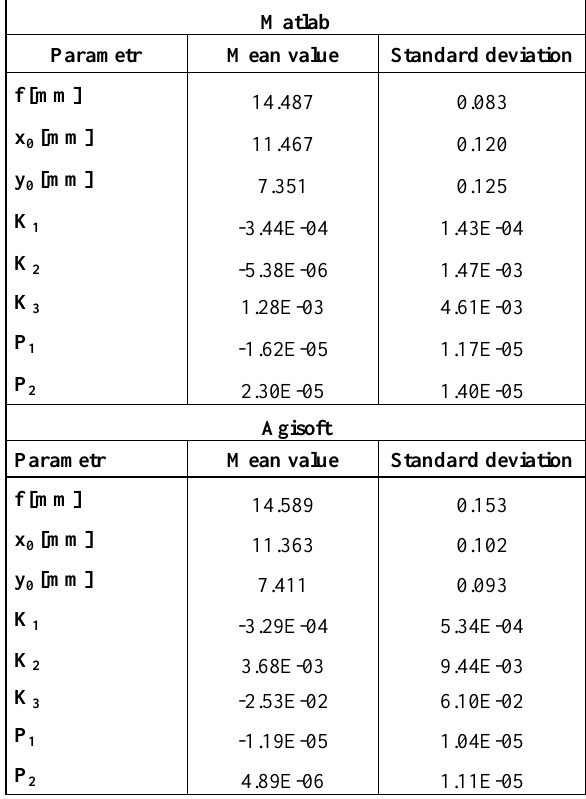
Table 4. The results of Sony NEX 5T calibration (Matlab and